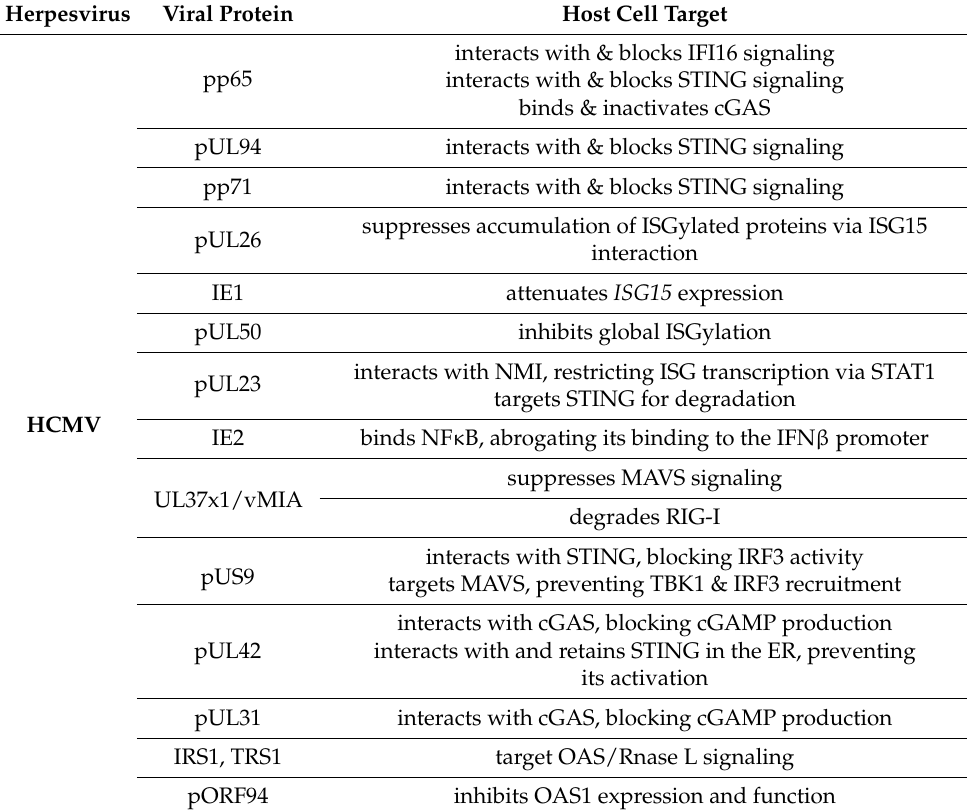
Table 2. Multiple HCMV-encoded proteins usurp the innate immune